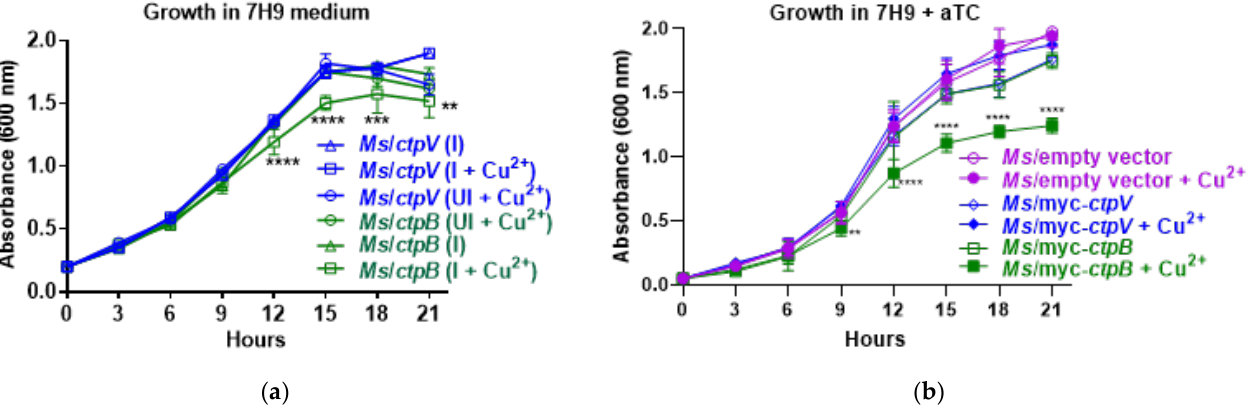
Figure 1. Heterologous expression of M. tuberculosis ctpB in M. smegmatis negatively impacts growth in copper-supplemented medium. ( a ) Strains of M. smegmatis encoding N-terminal myc -tagged M. tuberculosis ctpB or ctpV controlled from an aTC-inducible promoter ( Ms / ctpB and Ms / ctpV , respectively) were cultured in Middlebrook 7H9 medium and subcultured in fresh medium without (UI) or with (I) inducer aTC (2 µg/mL) and/or 0.1 mL CuCl 2 (Cu 2+ ) and growth was monitored by measuring absorbances at 600 nm. ( b ) Growth of strains of M. smegmatis expressing ctpB or ctpV without myc tags or the empty vector plasmid (vector) were subcultured in 7H9 medium with aTC (2 µg/mL) differences based on ANOVA with multiple comparisons for the indicated groups versus all others